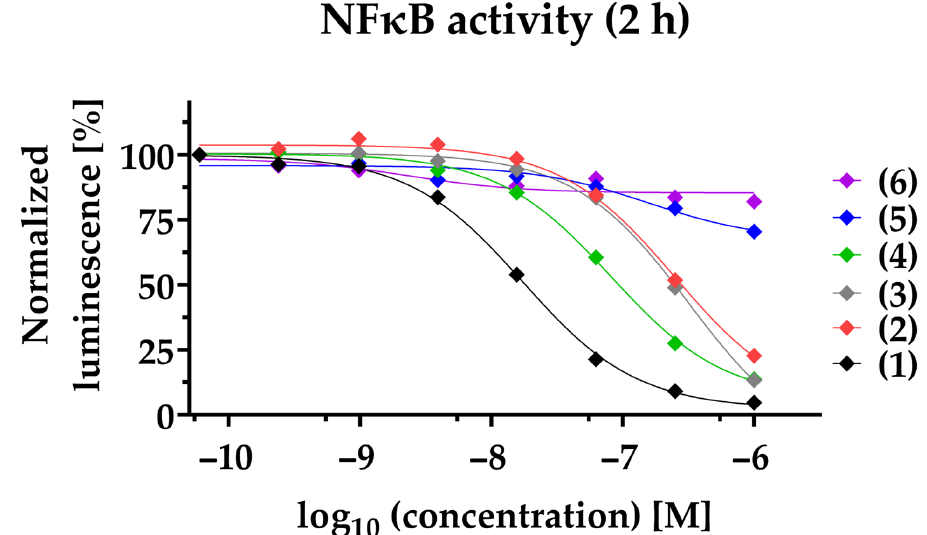
Figure 2. PAs inhibit NF κ B-dependent gene transcription. The NF κ B-dependent luciferase activity was quantified 2 h post-stimulation of NF κ B-MDA-MB-231-nanoluc cells. Compounds ( 1 )–( 6 ) were applied at a concentration ranging from 1000 nM to 0.06 nM before being stimulated for 2 h with 20 ng/mL TNF α . In each individual experiment, the NF κ B-dependent luminescence was normalized to the lowest concentration applied (100%). Each data point represents the mean of at least three independent